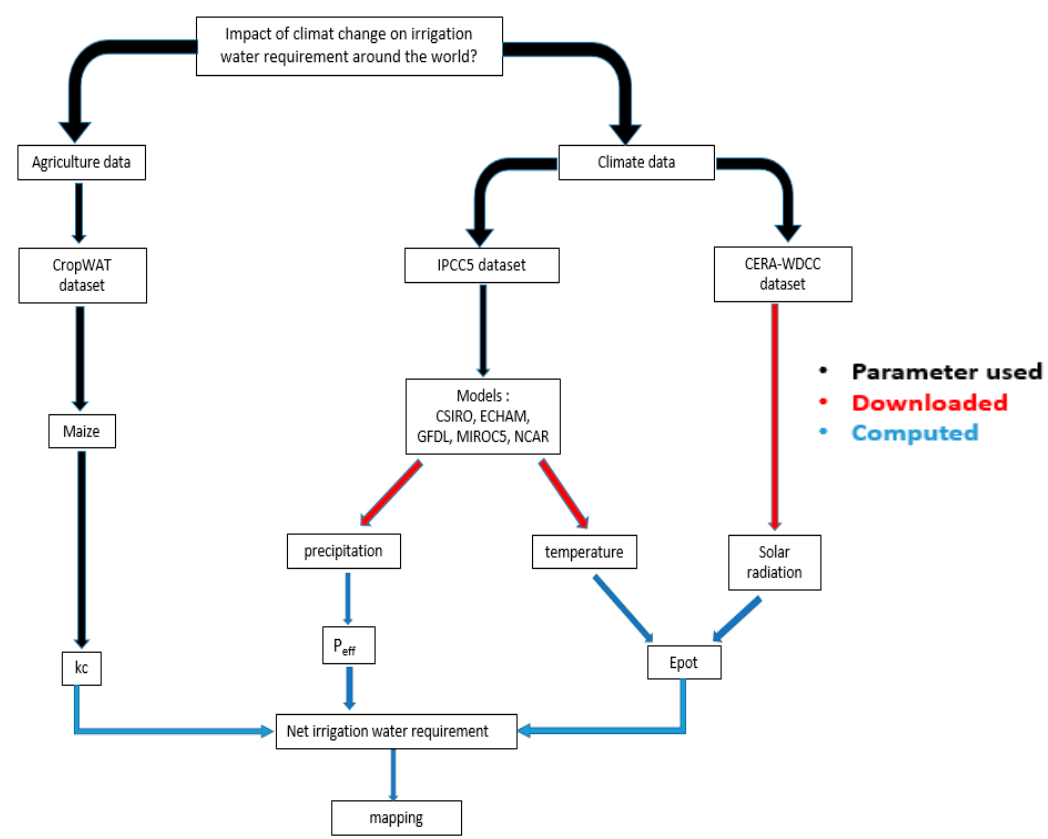
Figure 13. work chart. Diagram of our work which briefly shows the process of our work. Figure 13. Work chart. Diagram of our work which briefly shows the process of our work.